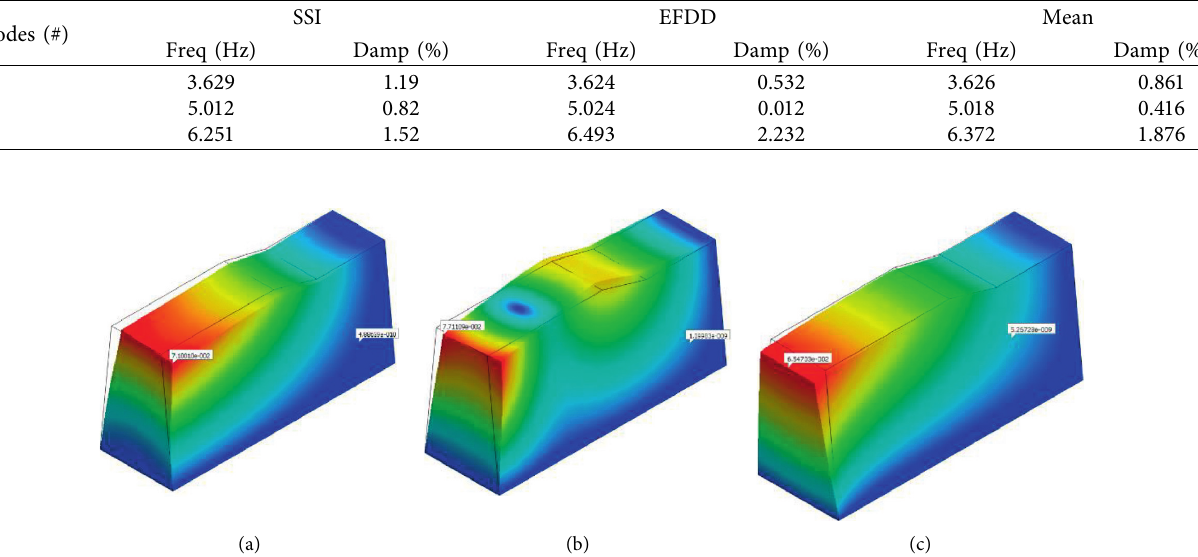
� 3.34Hz, (b) second-order left and right 1FEM